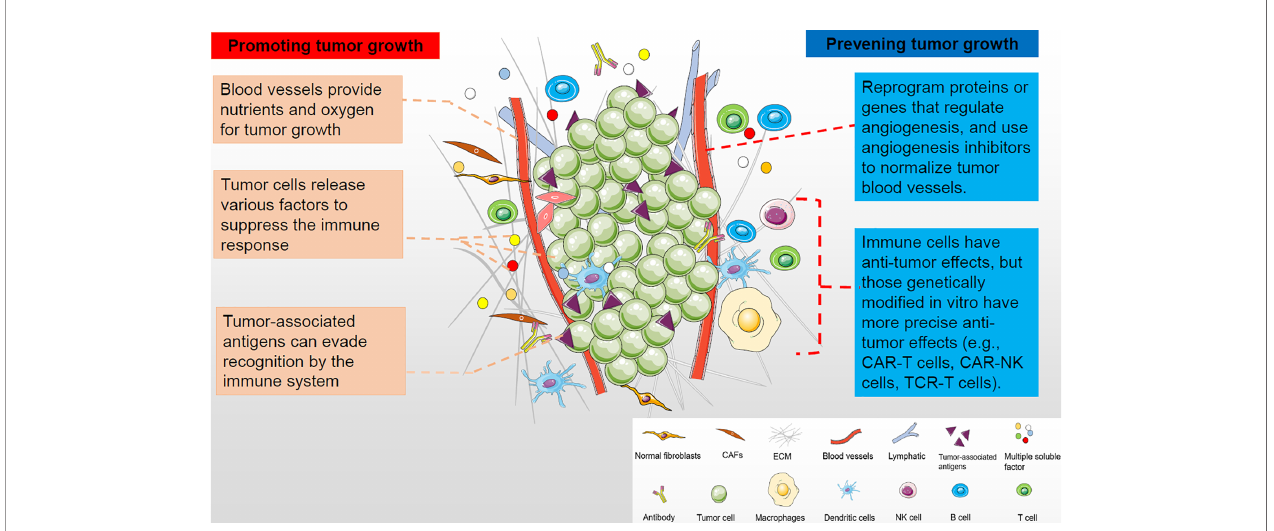
FIGURE 1 | The tumor microenvironment is composed of cellular and non-cellular components that support tumor growth. Tumor and its microenvironment interact and promote each other through angiogenesis and immunosuppression. Therefore, targeting tumor microenvironment in anti-tumor therapy can make greater progress, such as inhibiting tumor angiogenesis and tumor